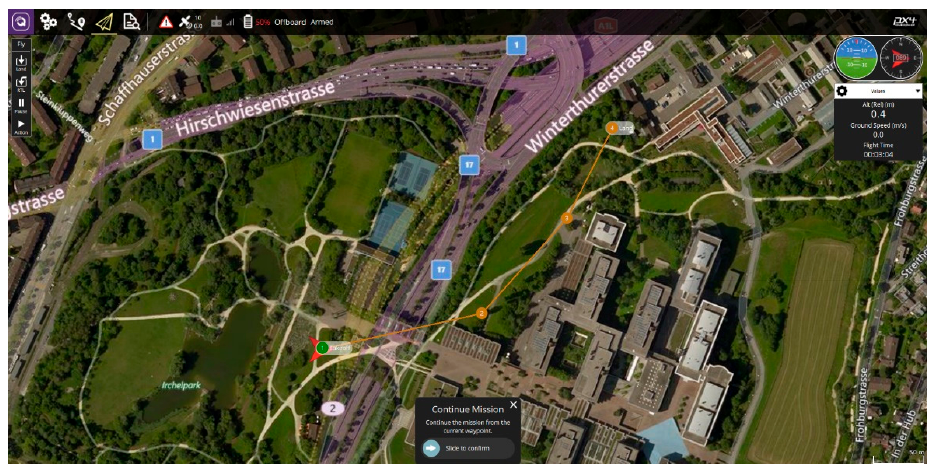
Figure 2. QGroundControl as the ground control station (GCS).